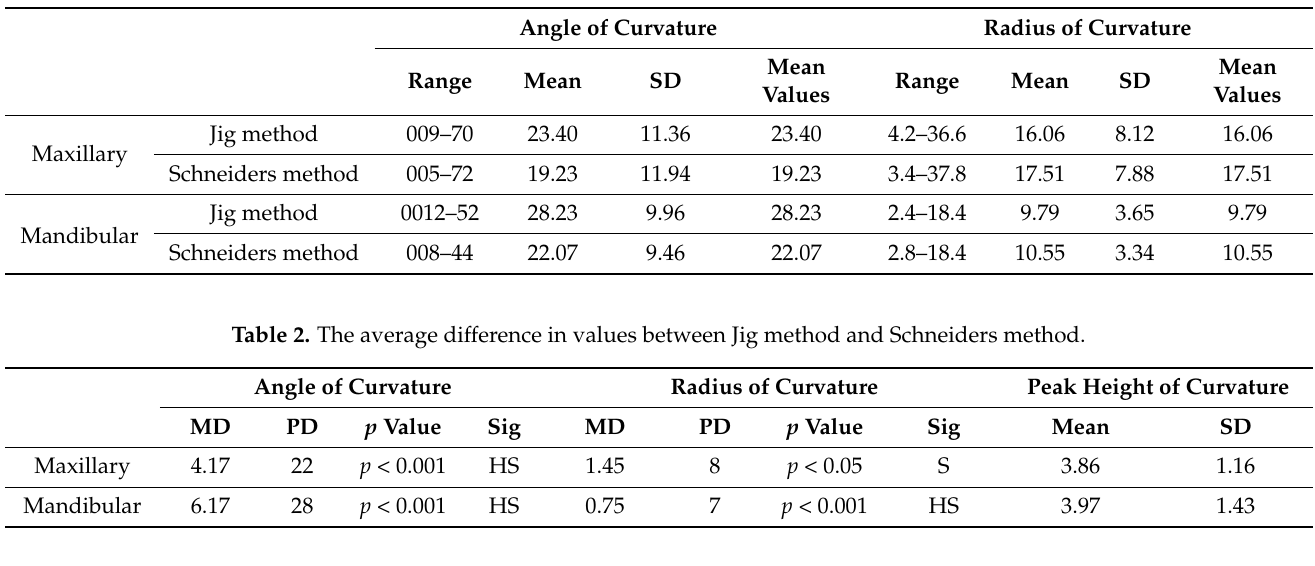
Table 1. Angle of curvature and radius of curvature measured using Jig method and Schneiders method.